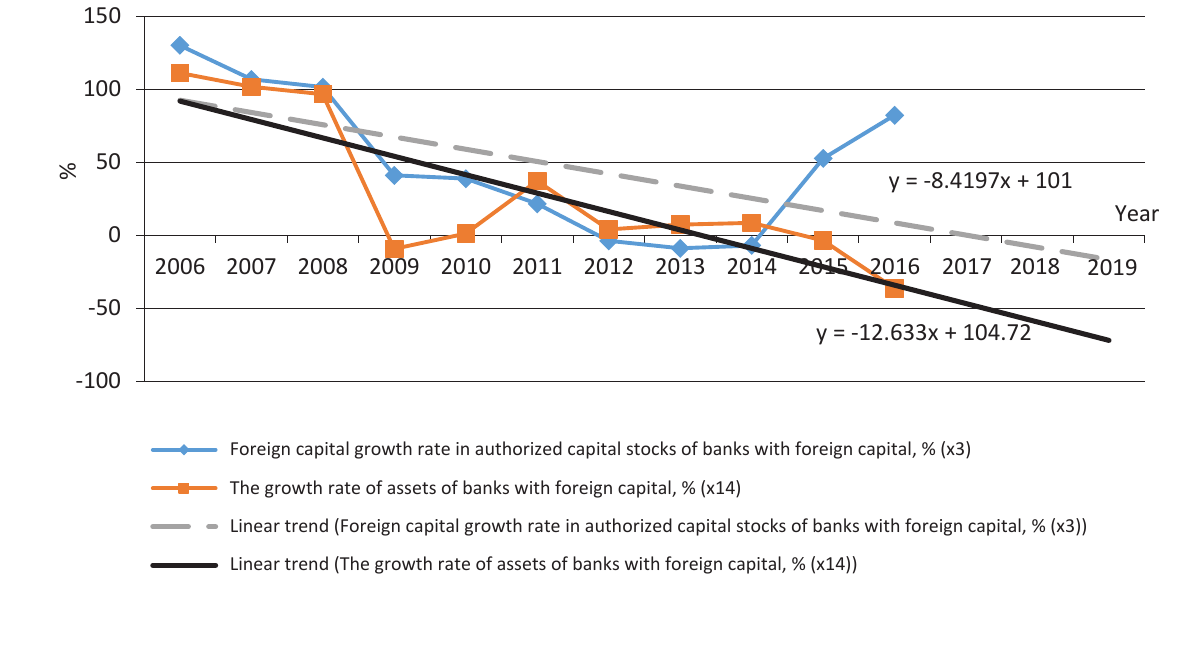
Figure 3. Trend analysis of growth rates of foreign banking indicators via construction of diagram reflecting the linear